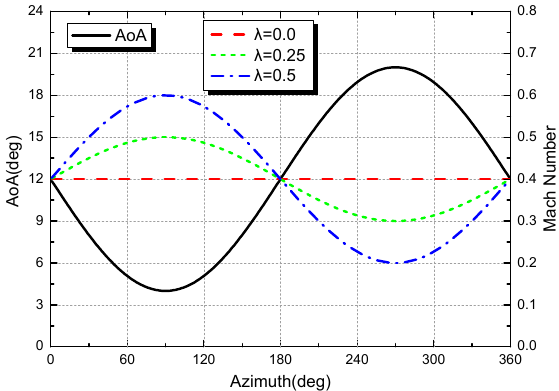
Figure 9. Comparison of Mach number variation with AoA.